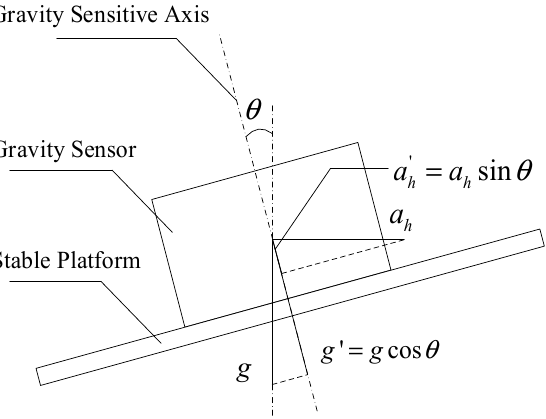
Figure 1. Gravity measurement of stable platform and gravity sensor installation relationship. If the gravity static measurement accuracy of 1 mGal is to be achieved, the horizontal misalignment angle must be less than 4.8 (cid:48) when the first item in Equation (1) is ignored. The magnitude of the first term in Equation (1) depends on the horizontal acceleration of the carrier and the extent of the error angle of the platform. If the gravity sensor’s damping mechanism is not considered, the maximum dynamic gravity measurement error should not exceed 1 mGal. When the horizontal acceleration of the carrier is a h = 0.1 m/s 2 , the error angle θ should be less than 20.6 (cid:48)(cid:48) . In actual measurement systems, the damping mechanism, such as silicone oil, is set in the gravity sensor, which gives the gravity mea- surement system a specific anti-interference ability against the horizontal acceleration of the carrier. In practical applications, the error angle θ does not need to be less than 20.6 (cid:48)(cid:48) . However, Equation (1) indicates that, in the case of the horizontal misalignment angle of the gravimetric measuring platform, the horizontal acceleration of the carrier has a non-negligible effect on the gravimetric measurement results. As large-weight instrumentation, a gravimeter requires a gravimetric stabilization platform with a hefty load capacity (more than 30 kg). The related research mainly studies the control algorithm of a small load, three-axis or airborne stabilization platform. There is less research on the control of high-precision stabilization platforms with enormous load capacities. Domestic and foreign research scholars have conducted relevant studies to reduce the stabilized platform’s control system error and improve the stabilized platform’s stabilization accuracy. In Ref. [8], a robust adaptive controller in the form of expectation compensation was proposed for accurate tracking control, to reduce the influence of measurement noise and to improve the control performance of the photoelectric gyro- stabilized platform system. In Ref. [9], a new decoupling algorithm, applied to the stabilized platform for aerial remote sensing, was used to solve the problems of unknown nonlinear interference and coupling interference, which occur in tasks such as aerial photography. In Ref. [10], a combination of sliding mode control and a neural network is proposed to deal with the uncertainty disturbances in the inertially stabilized platform (ISP) system model. The article also presents an adaptive neural network to approximate the uncertainty and unknown disorders of the system and improve control performance. An anti-disturbance control scheme for an airborne radar stabilization platform based on the inverse estimation algorithm of self-rejecting control (ADRC) is used to solve the stability and clarity problems of radar imaging [11]. An improved dynamic variational differential evolution algorithm (DMDE) is proposed to optimize the PID control parameters and is validated by simulation for several standard industrial-controlled object models [12]. An adaptive fuzzy PID composite control algorithm is proposed and applied to control gyro-stabilized platforms for resisting nonlinear disturbance factors in platform control [13]. A fuzzy PID